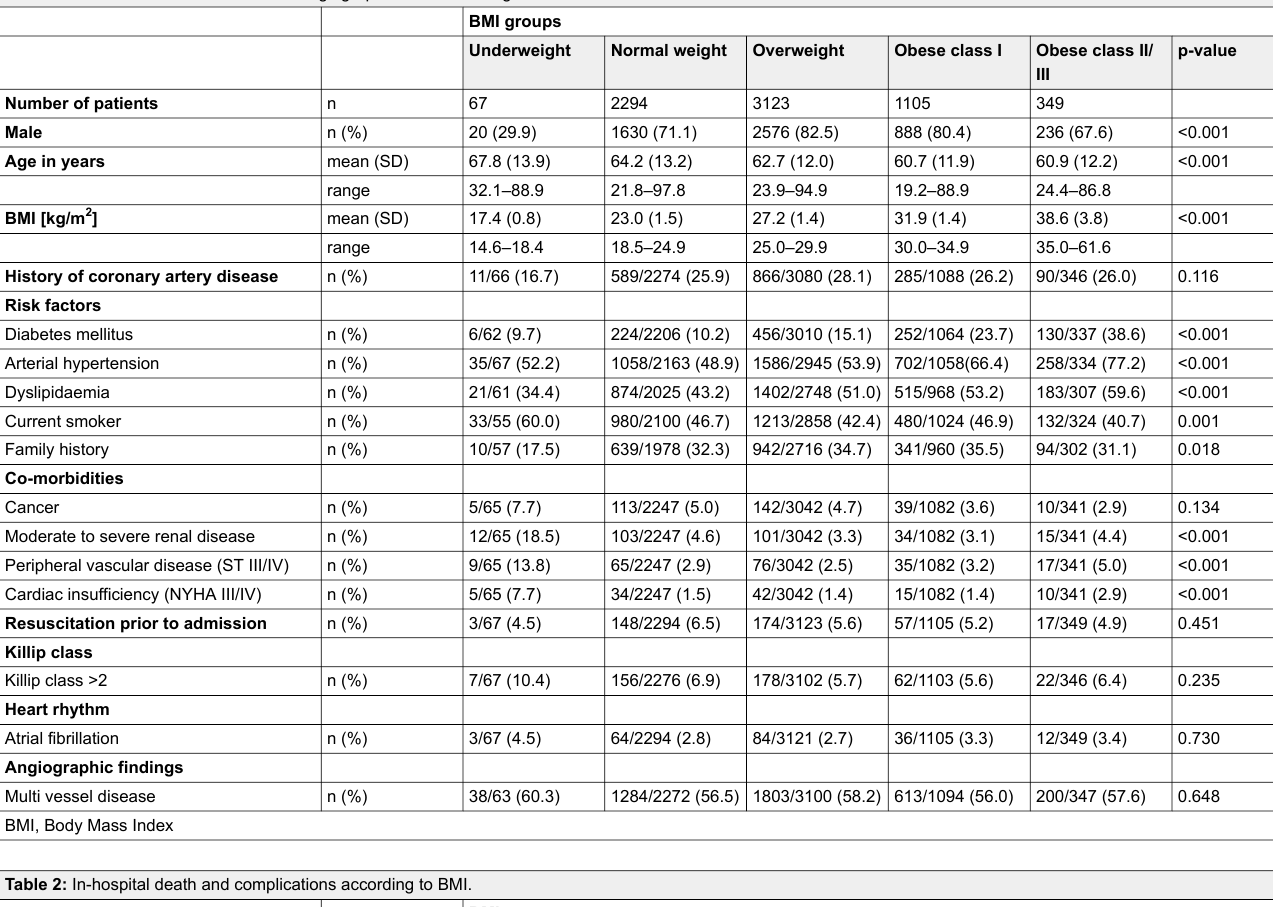
Table 1: Admission characteristics and angiographic data according to BMI.